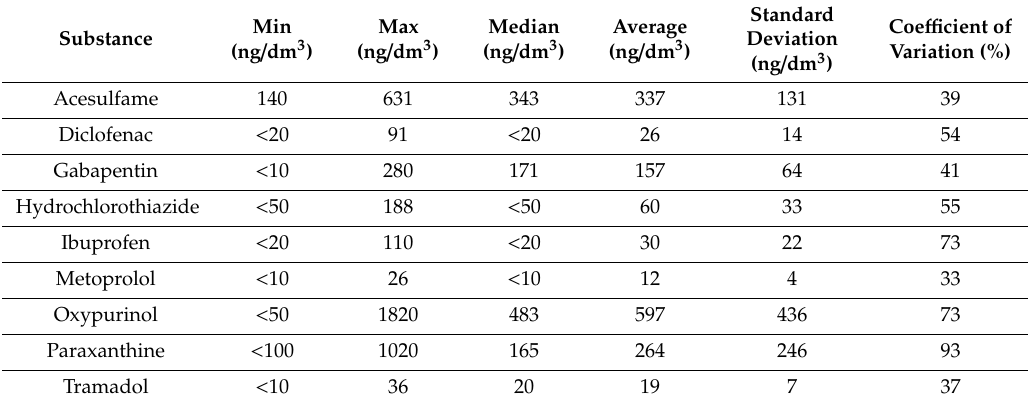
Table 8. Miletin Profile—basic statistical